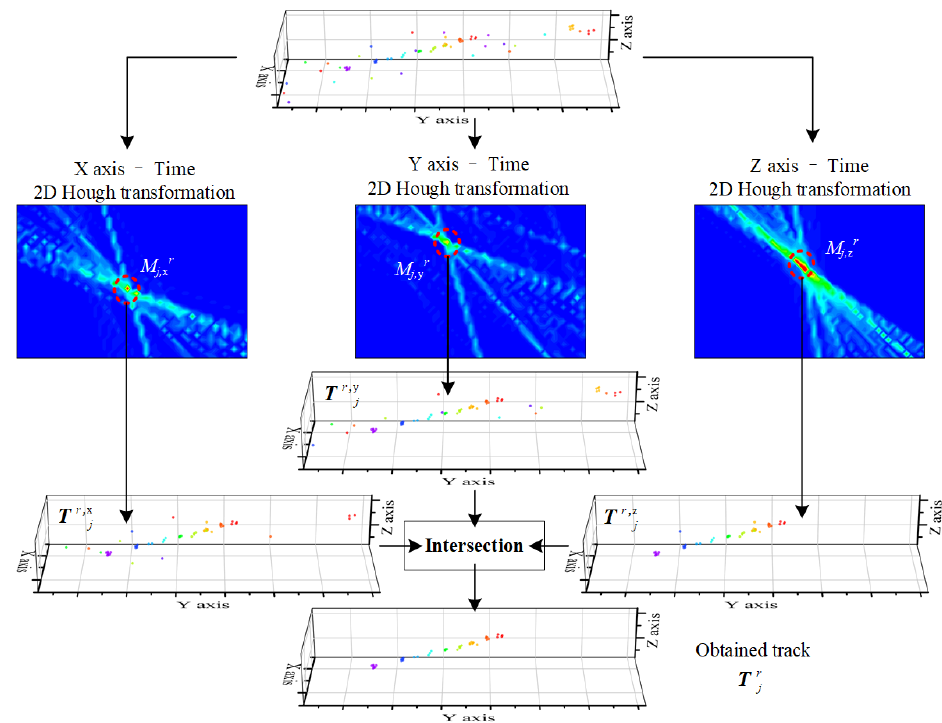
Figure 3. The 2D Hough transformation on three axes. The T 2 is applied to confirm the candidate target region in the 2D voting d